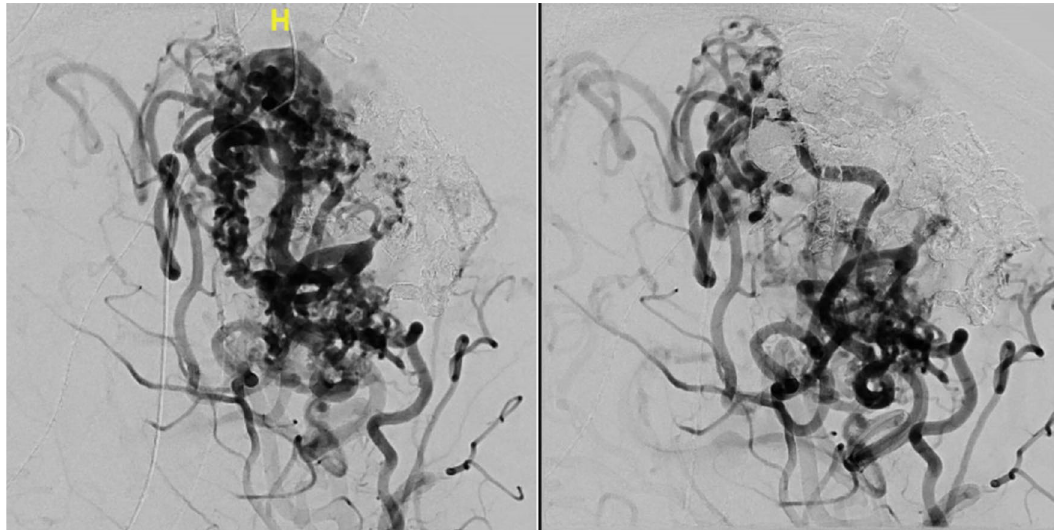
Fig. 10 DSA imaging. Before and after embolization with PCT via Kaneka coils in lateral